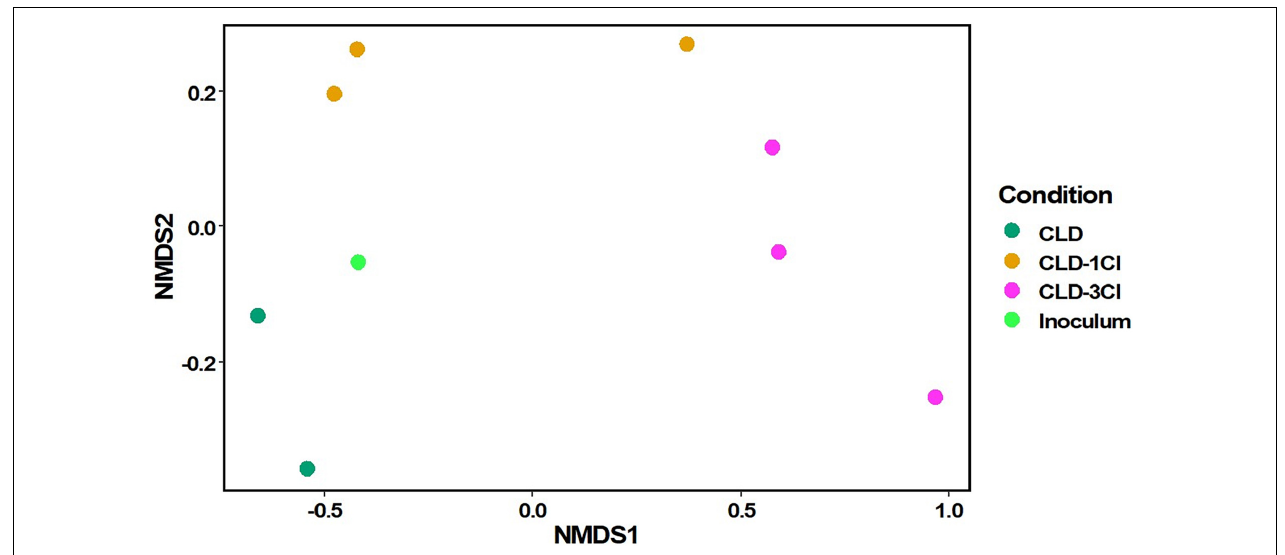
FIGURE 4 | nMDS ordination plot of bacterial community diversity in the different incubation conditions and the inoculum.